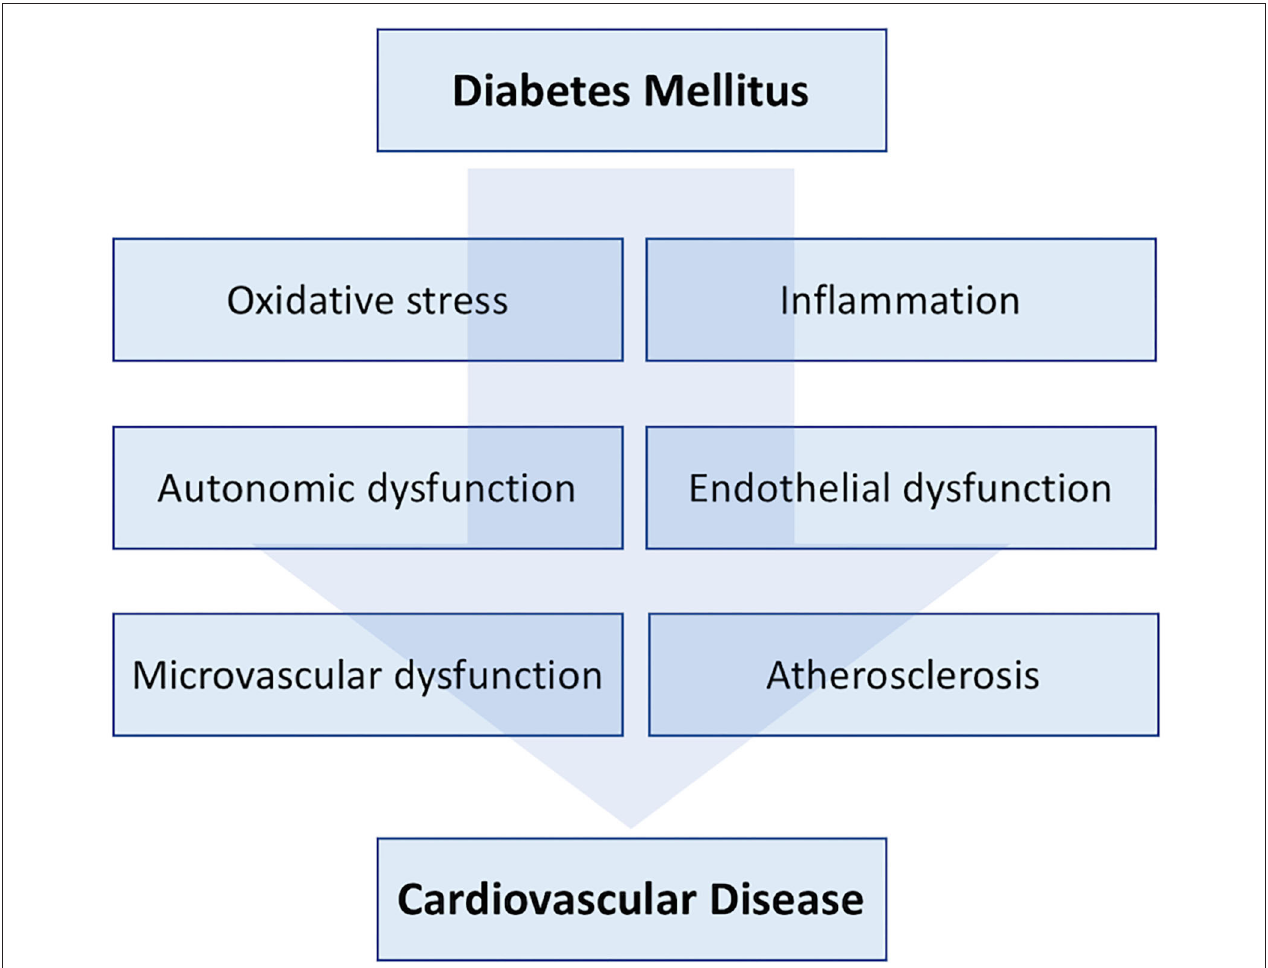
FIGURE 1 | From diabetes mellitus to cardiovascular disease. Brief summary of pathophysiological mechanisms involved in the development of cardiovascular damage during diabetes